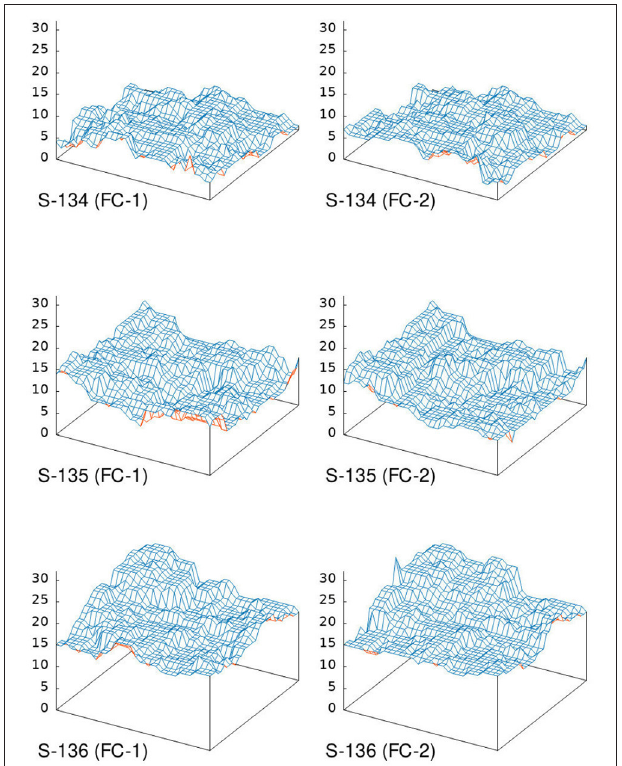
FIGURE 10 | Comparison of fracture surfaces obtained with different fracture criteria. Three different samples are shown, S-134, S-135, and S-136. FC-1 denotes the “maximum normal stress” criterion, Equation (84), and FC-2 denotes the “maximum shear stress” criterion, Equation (77). Fracture interfaces are red on the underside and blue on